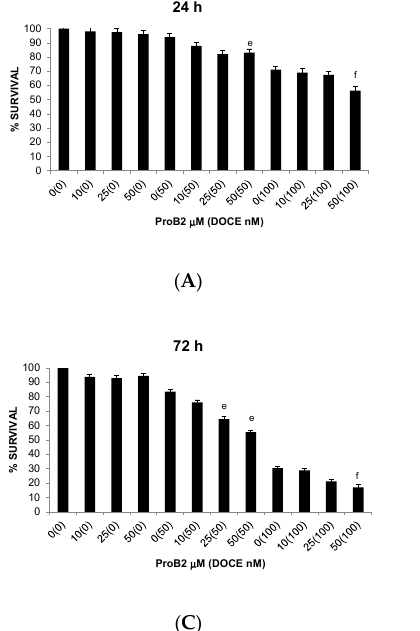
Figure 4. Trypan blue dye exclusion assay results showing viability of MDA-MB-231 cells under different concentrations of the test compound (ProB2, DOCE, ProB2 + DOCE) at 24 h ( A ), 48 h ( B ) and 72 h ( C ). Columns, mean; bars, SE (n = 3). e represents the significant difference between combination treatment (ProB2 + DOCE 50 nM) and 50 nM DOCE alone; f represents the significant difference between combination treatment (ProB2 + DOCE 100 nM) and 100 nM DOCE alone ( p < 0.05; one-way ANOVA). Abbreviations: DOCE, docetaxel; ProB2, procyanidin B2.